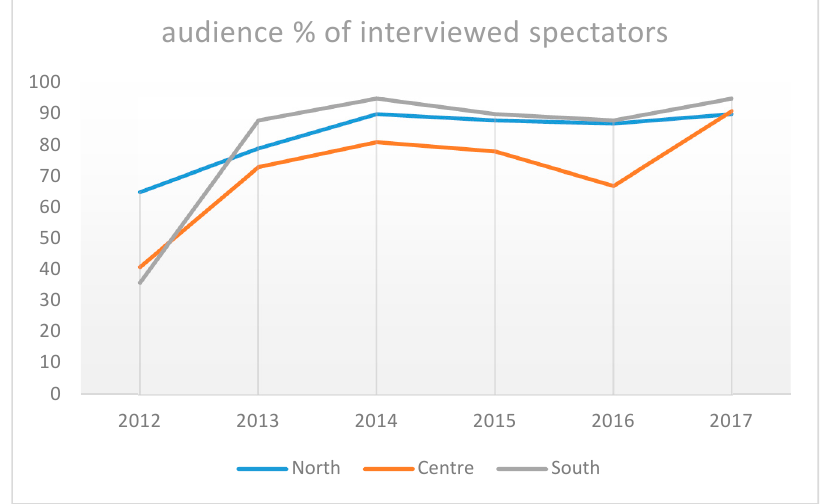
Figure 6. Percentage audience of interviewed cycling supporters, linked to Italian Macro-Areas.